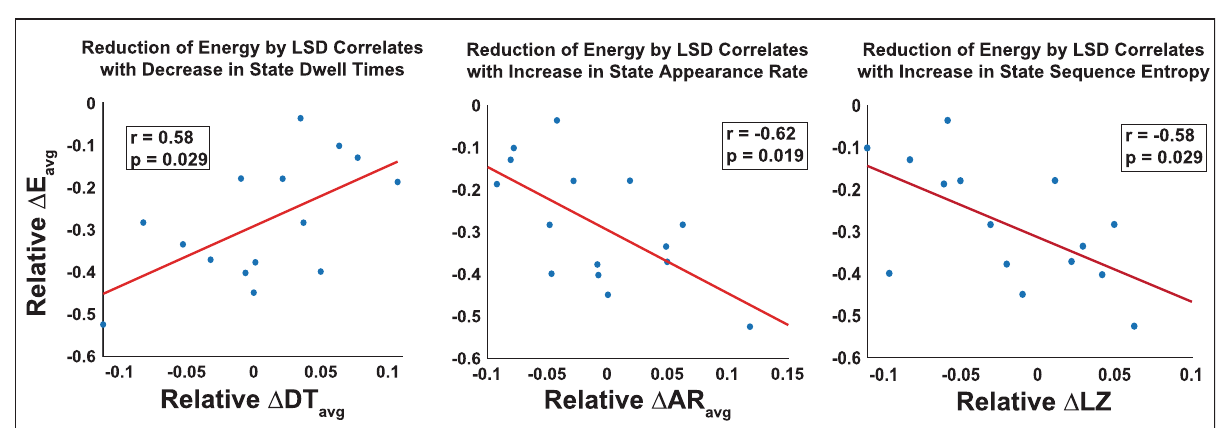
Fig. 6 | Larger reduction of average transition energy by LSD correlates with more dynamicbrain activity across individuals. Signi fi cant Pearsoncorrelations exist between an individual ’ s amount of energy reduction by LSD and the relative change in state (left) dwell times, (center) appearance rates, and (right) entropy of the brain state time series. Relative difference was calculated as (LSD − PL)/(LSD+